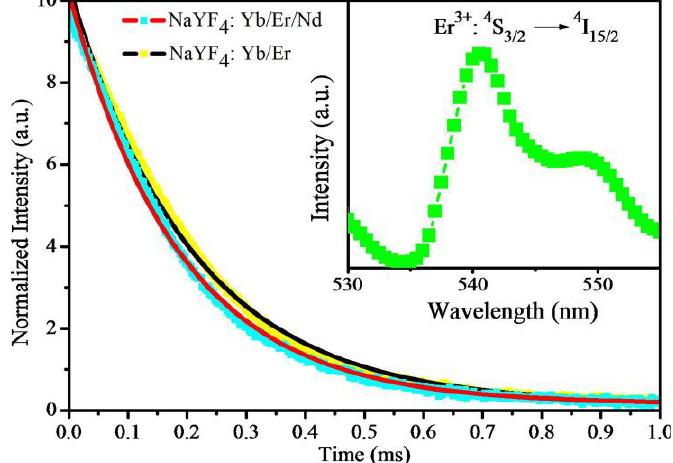
Figure 6. Luminescence decay curves of Er 3+ : 4 S 3/2 → 4 I 15/2 transition in NaYF 4 : Yb/Er (20/2 mol%) nanoparticles with and without Nd (0.5 mol%) co-doping. The inserted image